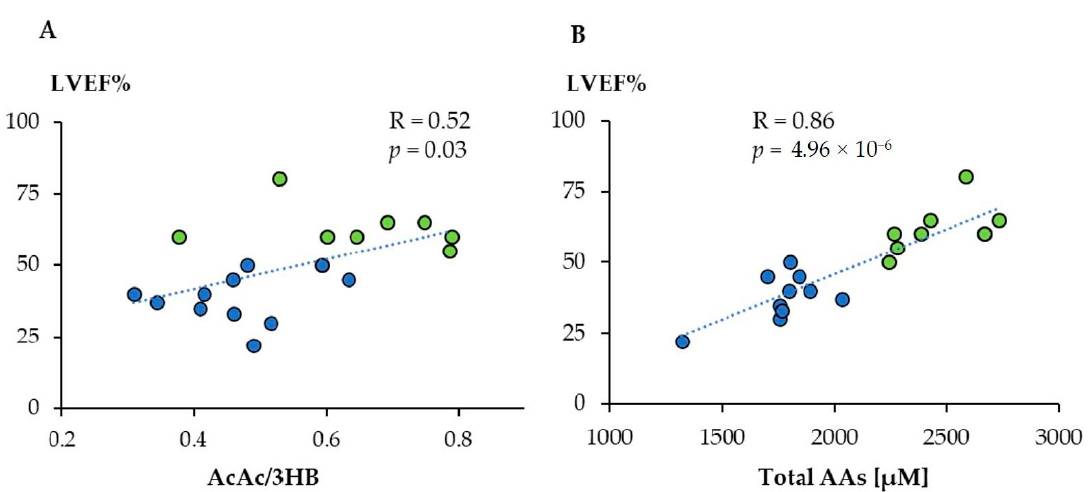
Figure 5. Linear correlation between acetoacetate/3-hydroxybutyrate ratio (AcAc/3HB) ( A ) and total amino acid concentration ( B ) with LVEF%. Green dots: controls; blue dots: TTS. (Reprinted with permission from Vanni D et al. Antioxidants (Basel). 2021, 10, 1982).